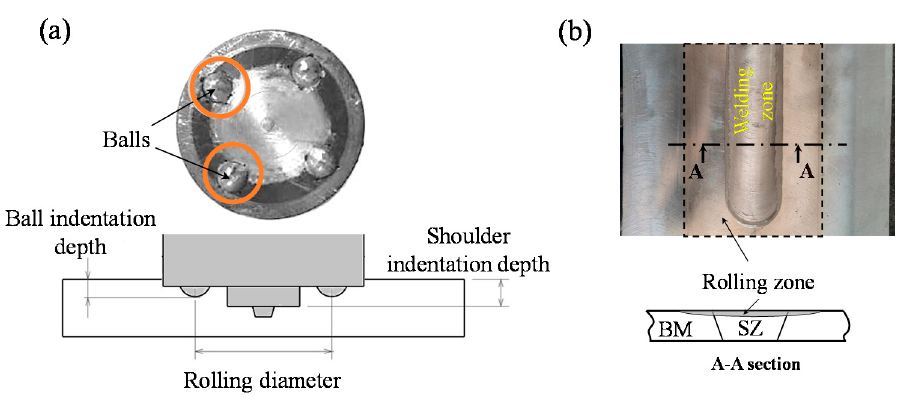
Figure 1. ( a ) Rolling tool and schematic view of tool-joint; ( b ) top view of the rolled joint and its cross-section.